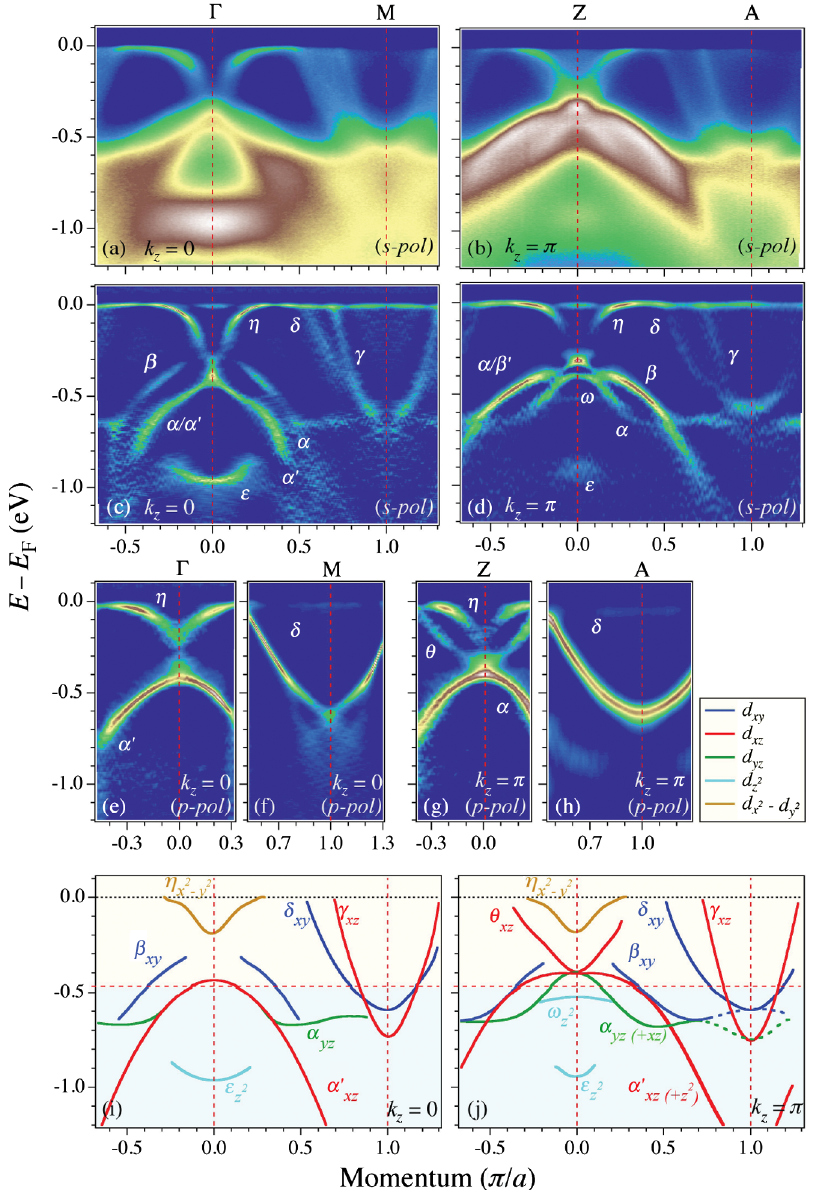
FIG. 2. (a),(b) ARPES intensity plots of BaCo 2 As 2 along (cid:1) -M and Z-A, respectively, recorded in the s polarization ( s-pol ) geometry. (c),(d) Corresponding 2D curvature-intensity plots [17]. (e)–(h) 2D curvature-intensity plots for data recorded with p polarization ( p-pol ) around (e) (cid:1) , (f) M, (g) Z, and (h) A. (i)–(j) Band dispersions extracted from MDC fits along (cid:1) -M and Z-A, respectively, along with their orbital characters determined from LDA calculations and the polarization